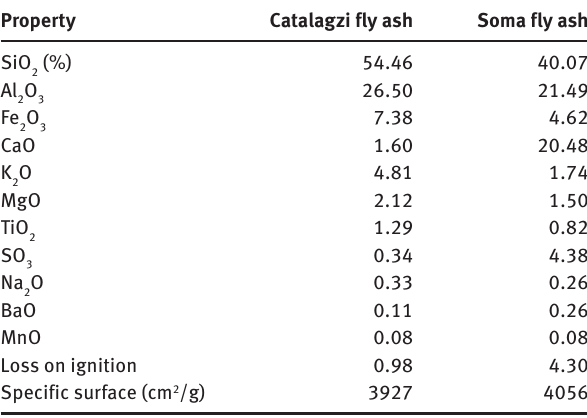
Table 2: Chemical composition of the fly ashes. Property